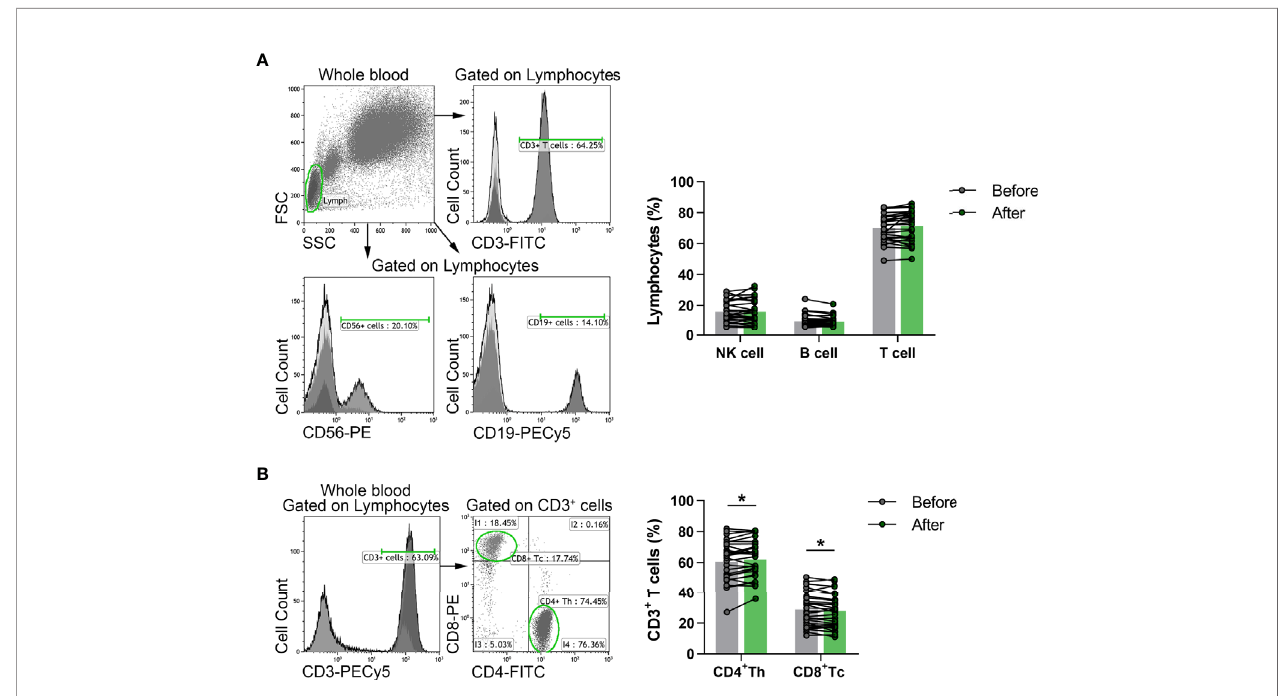
FIGURE 2 | The distribution of peripheral lymphocyte subsets in elderly women before and after the exercise program. Whole blood of 29 participants were stained with fl uorochrome-conjugated monoclonal antibodies as described previously. CD56 + NK, CD19 + B and CD3 + T cells were quanti fi ed as their percentage in the lymphocyte population, while CD4 + Th and CD8 + Tc cells were quanti fi ed as their frequencies in CD3 + cells. (A) Representative dot plots and histograms show the gating strategy of NK, B and T cell populations. The bar chart shows the percentages of NK, B and T cells. (B) Representative histogram shows the gating strategy and the dot plots demonstrate the distribution of Th and Tc cells. The bar chart indicates the frequencies of Th and Tc cells. Paired T test was used for statistical analysis. Each data point represents an individual subject, while bars show the mean values. Statistically signi fi cant differences are indicated by *p <